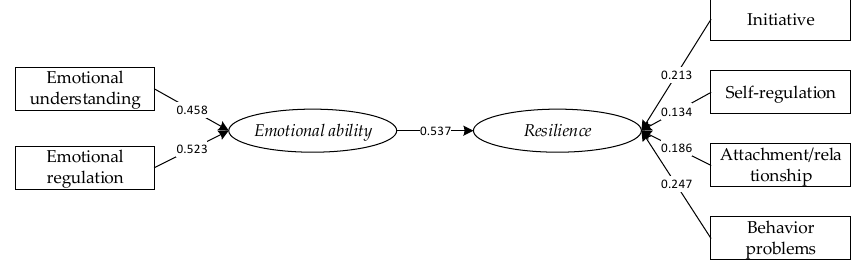
Figure 3. Hypothesis